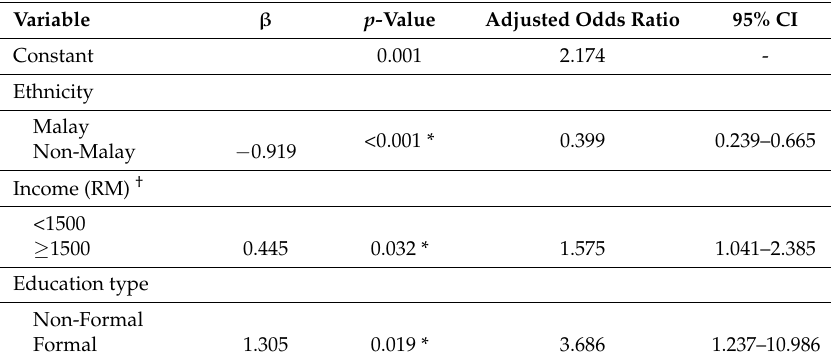
Table 5. Multiple logistic regression predicting the attitude on